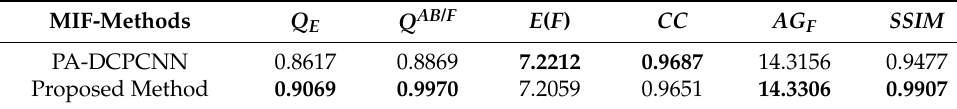
Table 6. The results and comparisons for flower image ([20]).